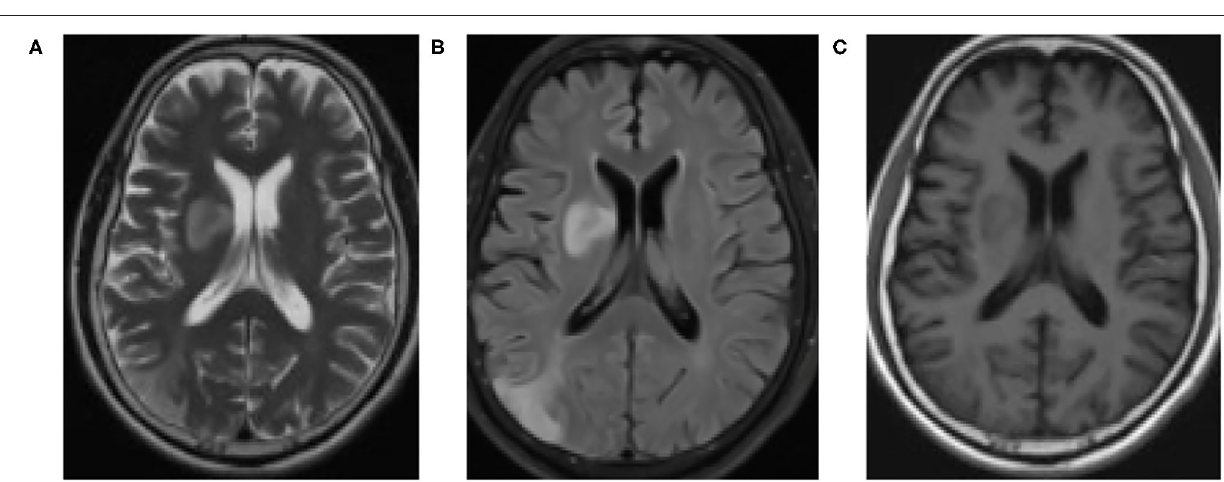
55.89 s, and that of the DRCNN algorithm was 15.76 s. The difference between the two was significant ( P <